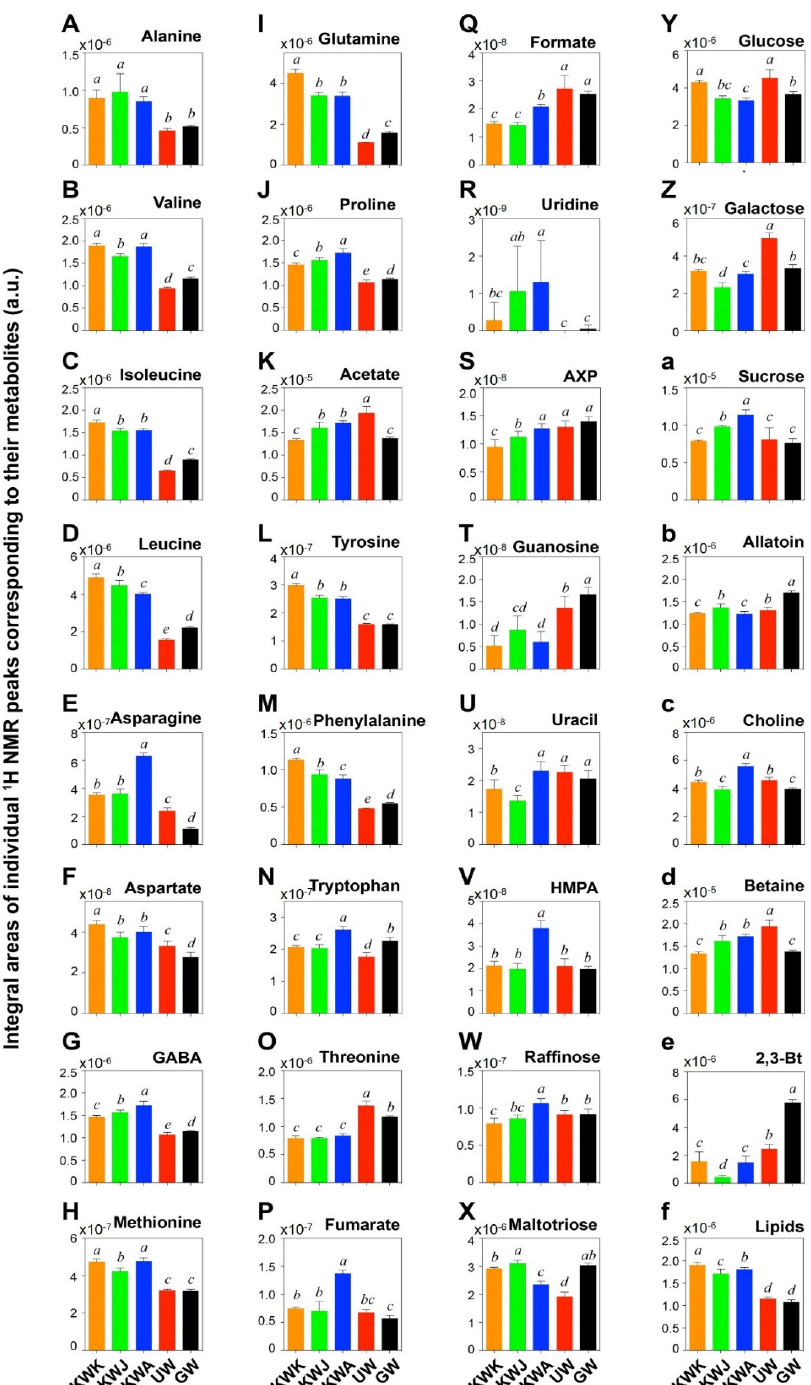
Figure 6. Relative amounts of individual metabolites calculated from integral areas of 1 H NMR. peaks corresponding the metabolites in extract of various wheat malts and their statistical differences. KWK: Korean wheat malt (var. Keumkang ), KWJ: Korean wheat malt (var. Jokyung ), KWA: Korean wheat malt (var. Anzunbaengi ), UW: US wheat malt, GW: German wheat malt. Different superscripts within the same row represents significantly different at p < 0.05 by Duncan’s multiple range test. The ‘a.u.’ is the abbreviation of arbitrary unit.